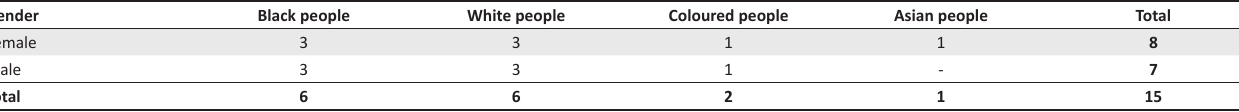
TABLE 2: Biographical information of the sample. Gender Black people White people Coloured people Asian people